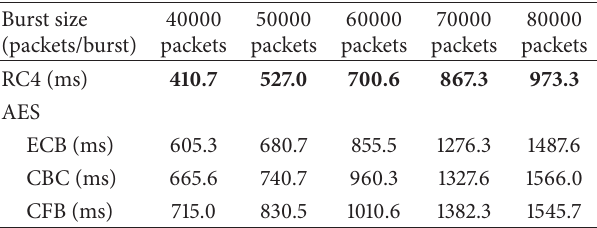
Table 7: Burst decryption time using RC4 and AES.